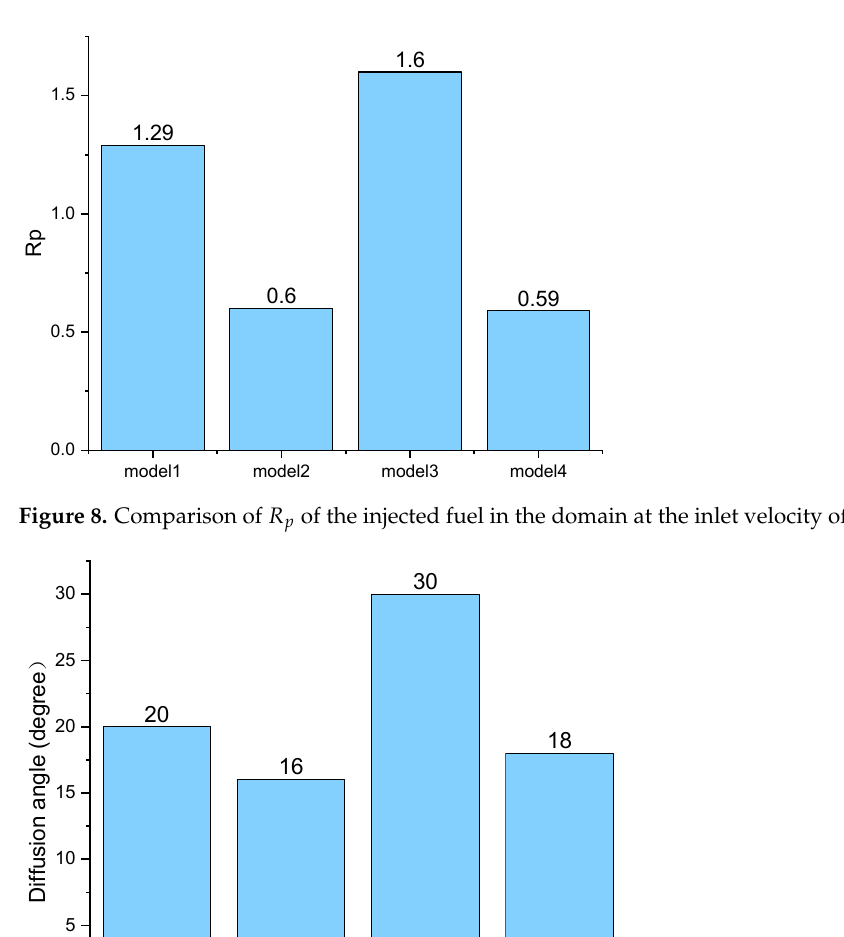
Figure 9. Comparison of diffusion angles of the injected fuel in the domain at an inlet velocity of 300 m/s.